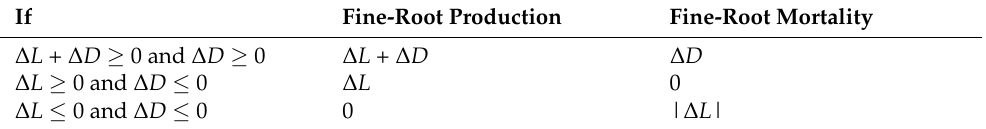
Table 1. Simplified decision matrix for the calculation of the production and mortality of the fine roots. If Fine-Root Production Fine-Root